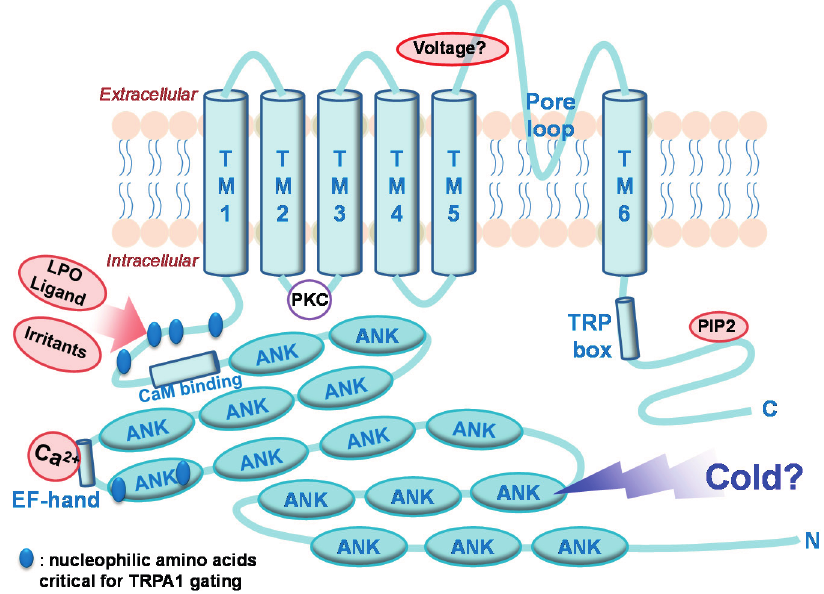
Figure 1. Transient receptor potential (TRP)A1 topology highlighting key domains, phosphorylation sites, and ligand binding pockets that affect gating functions. Abbreviations: TM, transmembrane domain; LPO, lipid peroxidation; ANK, ankyrin repeat; CaM binding, calmodulin binding site; PIP2, phosphatidylinositol 4,5-bisphosphate; PKC, substrate regions for protein kinase C actions; TRP box, conserved amino acids in TRPA, TRPC, TRPV, and TRPM subfamilies; Voltage, predicted voltage-sensing